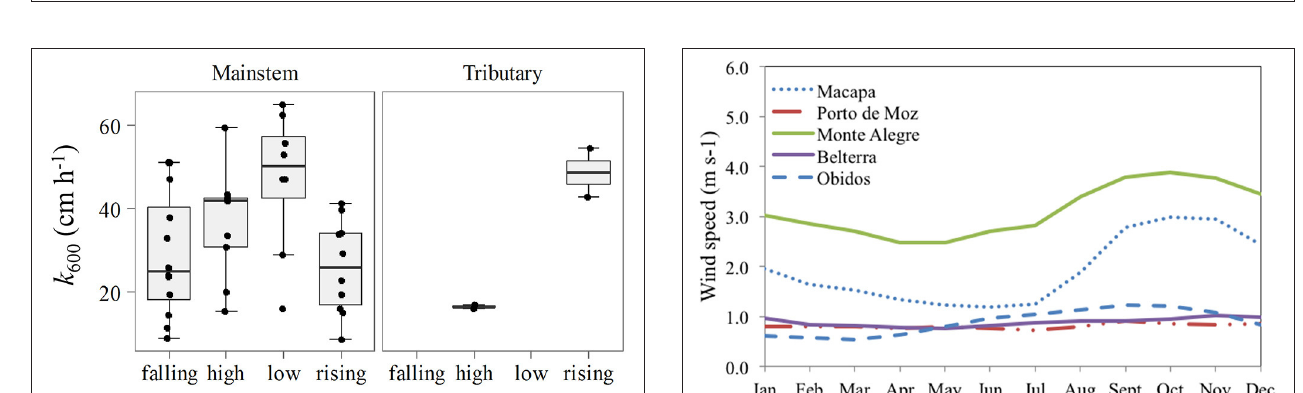
FIGURE 6 | Monthly averages from 2000 to 2016 of wind speed measured in stations located in the lower Amazon. Belterra station located near Tapajos River, Porto de Moz in Xingu River and Óbidos, Monte Alegre and Macapá in the Amazon